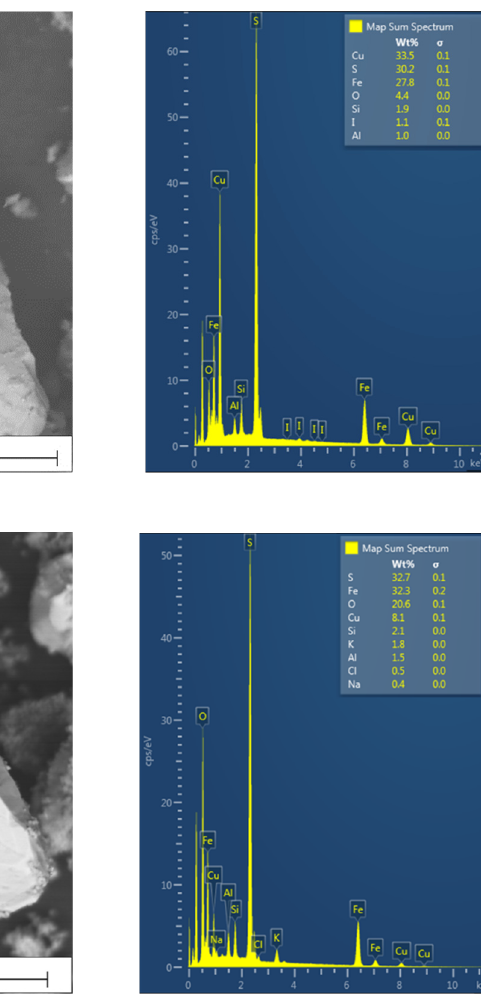
Figure 18. SEM and EDS analyses of chalcopyrite particles with ( a ) H 2 SO 4 = 0.1 M and ( b ) H 2 SO 4 = 1.0 M. [Conditions: 100 ppm of KI, 45 °C, 50 g of sample, 1000 mL of solution with seawater, 450 rpm].